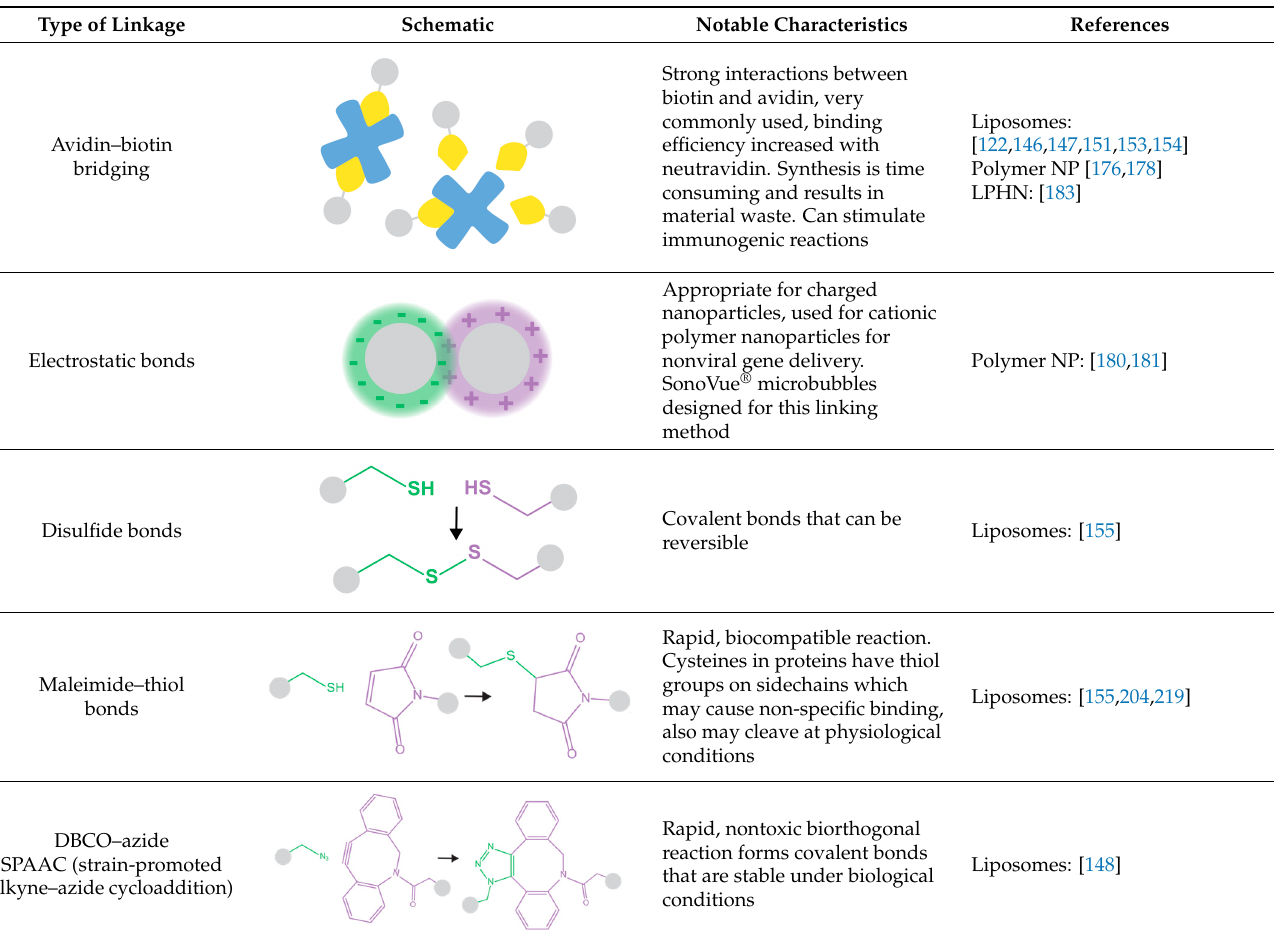
Table 2. Microbubble–nanoparticle (NP) linking strategies.